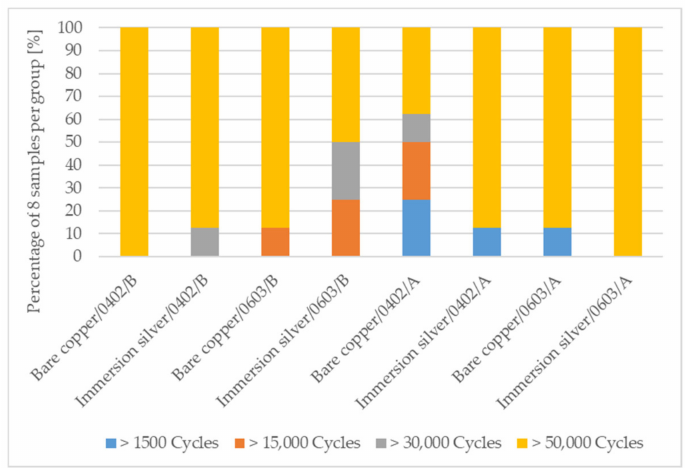
Figure 9. Achieved dynamic bending cycles to failure in categories for the different process variation for conductively bonded SMDs on